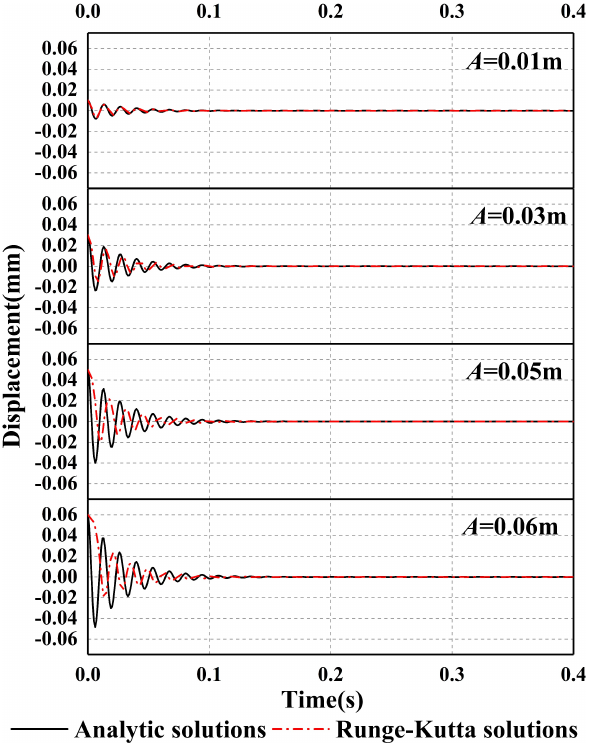
Figure 2: Comparison of analytical and numerical solutions